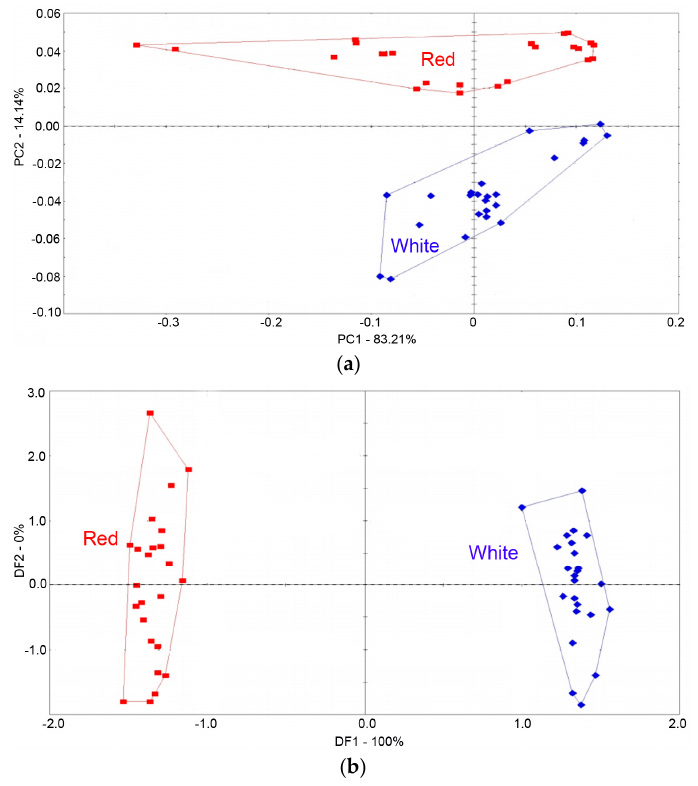
Figure 2. Multivariate analysis of peach fruit volatile compounds measured by e-nose. ( a ) PCA score plot, ( b ) DFA score plot.